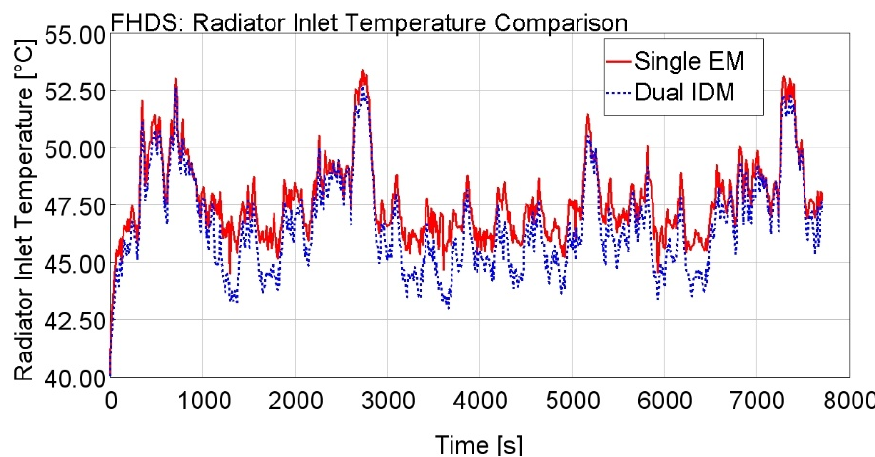
Figure 22. Impact of modularity and optimized control strategy on the coolant temperature at the radiator inlet for the FHDS driving cycle.